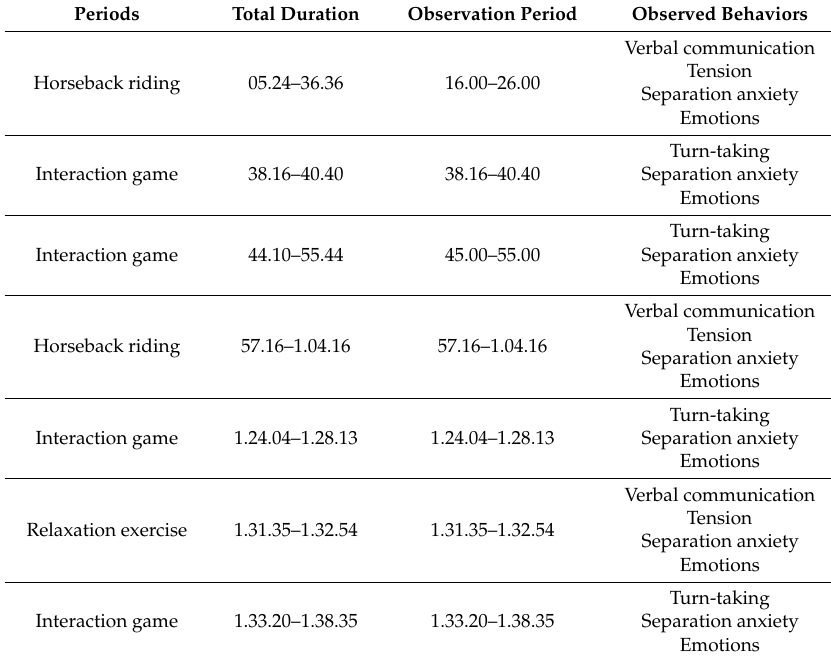
Table 1. Example of observation periods and behaviors during session